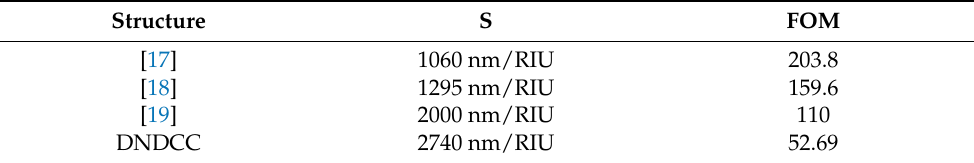
Table 2. Comparison of sensing parameters for different